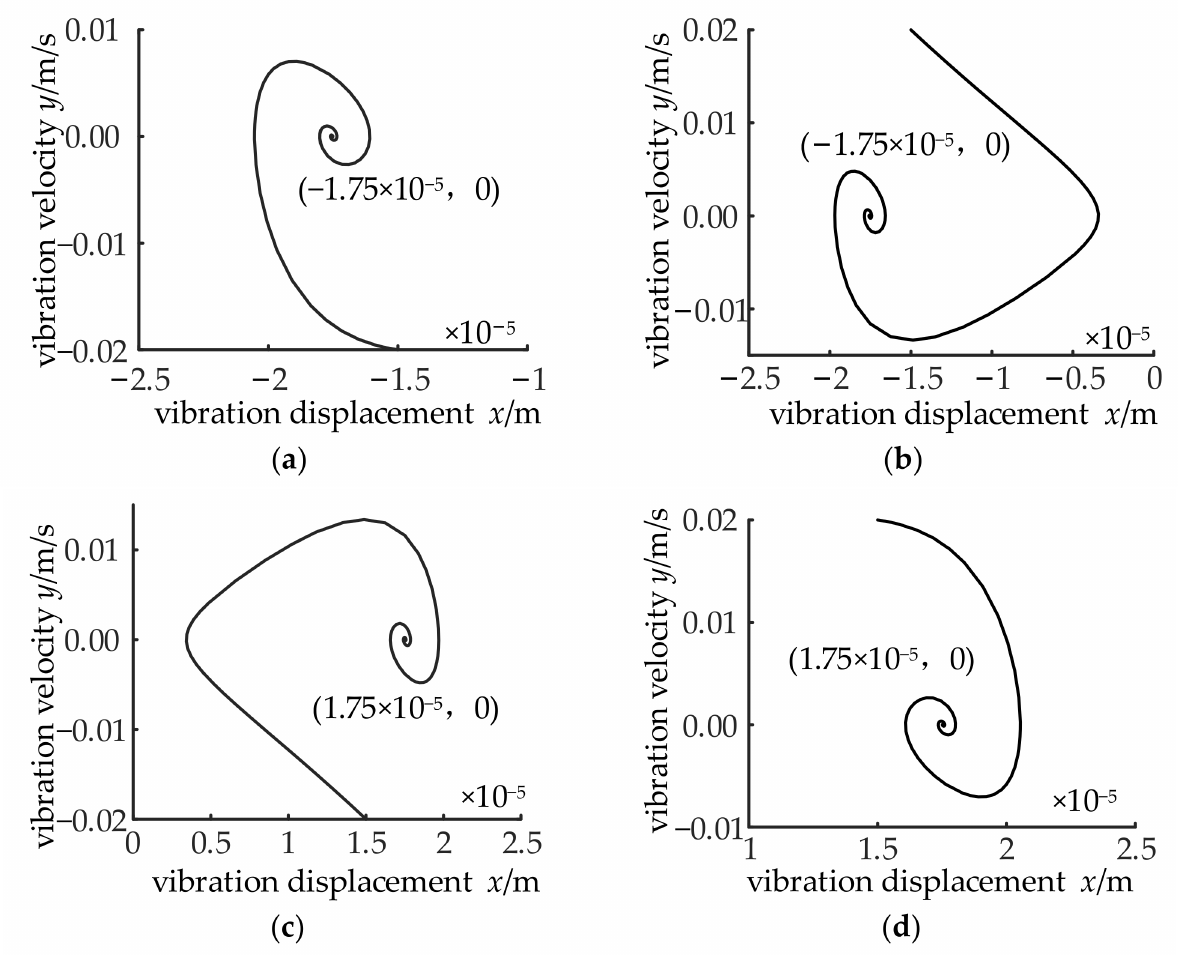
Figure 9. Phase trajectories when K p = 30. ( a ) ( − 1.5 × 10 − 5 , − 0.02). ( b ) ( − 1.5 × 10 − 5 , 0.02). ( c ) (1.5 × 10 − 5 , − 0.02). ( d ) (1.5 × 10 − 5 ,